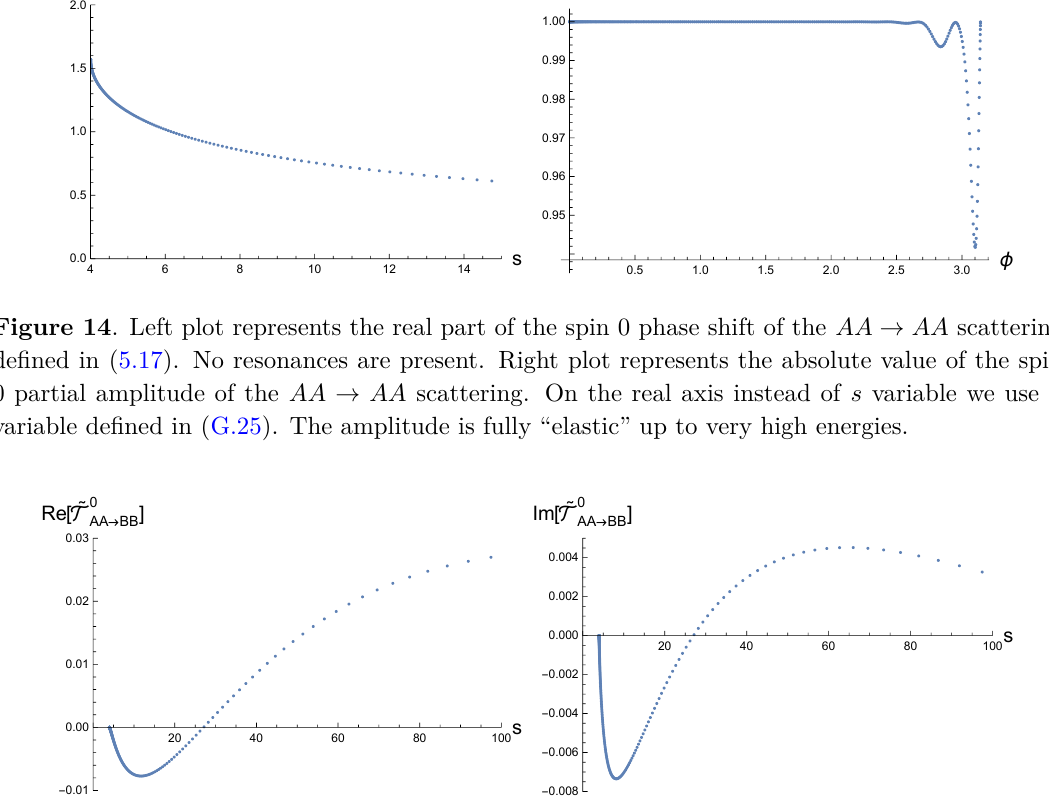
Figure 15 . Real and imaginary parts of the spin 0 interacting part of the AA → BB partial amplitude for λ 0 = 2 . 66 which leads to a/a free = 1 . 2002 . It is constructed for N max = 20 and L max = 30